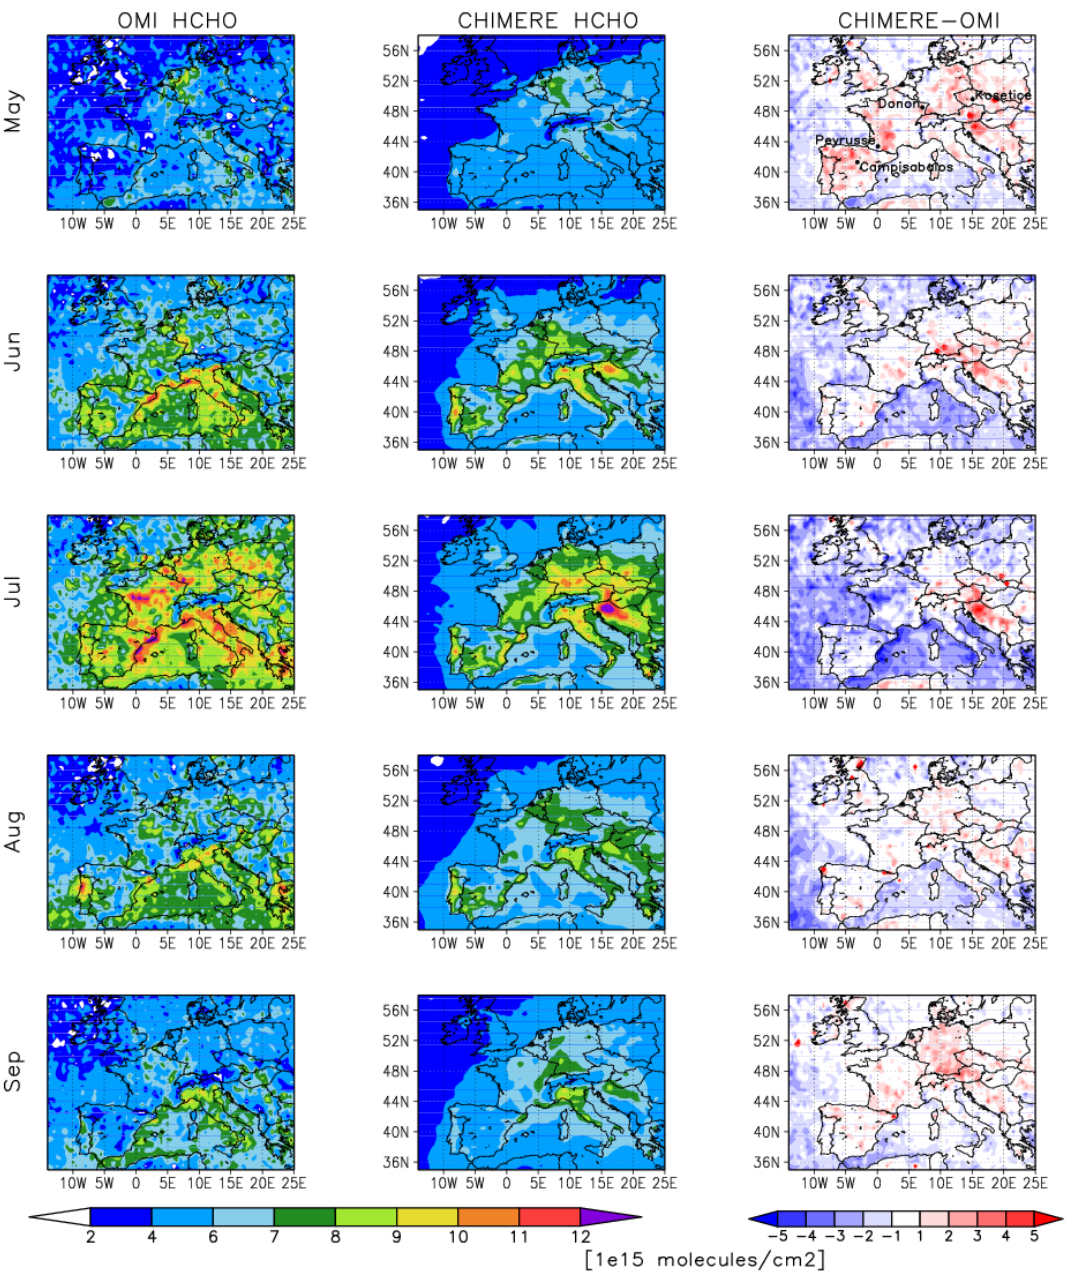
Fig. 2. Comparison of OMI and model monthly mean HCHO columns (10 15 moleculescm − 2 ) during May–September 2005. OMI columns 35 are mapped onto the same 0.5 ◦ × 0.5 ◦ grid of the model with daily frequency, with the model sampled at the time and location of OMI Fig. 1. Comparison of EMEP surface measurements of HCHO (left) and isoprene (right) (black circles) with the CHIMERE model during May–September 2005 with standard (a-priori) emissions (red squares) and with OMI-corrected (a-posteriori) emissions (blue crosses). Latitude and longitude of monitoring stations, and bias and correlation of model results with respect to observations are shown inset.